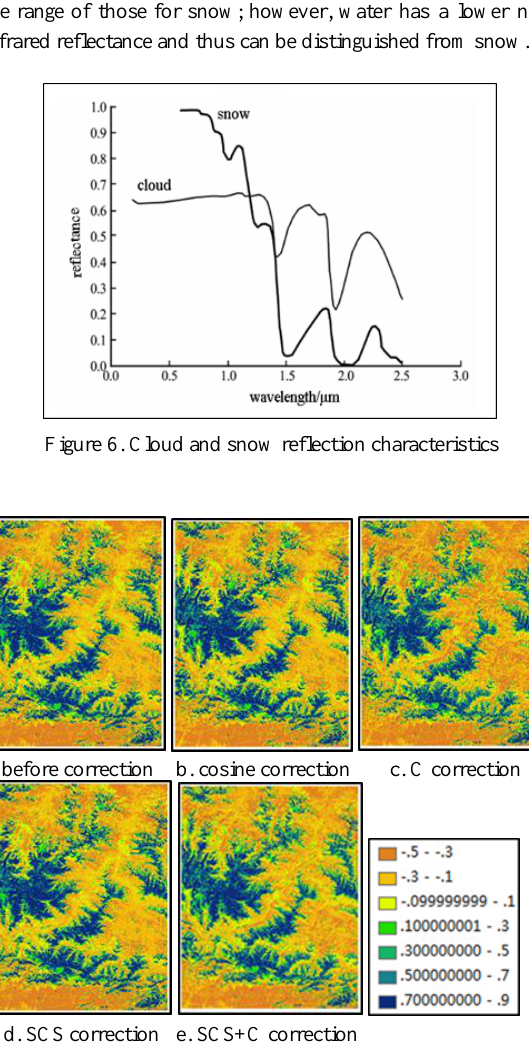
Figure 7. NDSI comparison and after topographic